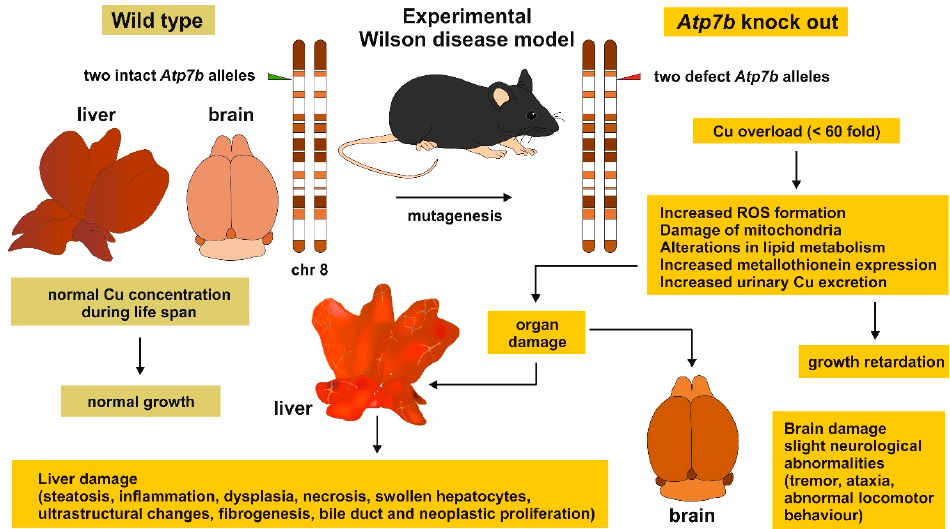
Figure 5. Atp7b − / − mice as a useful model for studies on Wilson disease. In mice, the genetic disruption of both Atp7b alleles located on chromosome 8 results in a phenotype resembling human Wilson disease. Respective mice display a gradual accumulation of Cu in liver, brain, and other organs. This provokes increased formation of reactive oxygen species (ROS), mitochondrial damage, measurable alterations in lipid metabolism, elevated metallothioneine expression, and increased urinary Cu excretion. As a consequence, Cu overload provokes liver and brain damage. In contrast, in wild type mice, Cu concentration is more or less stable in the complete life span.